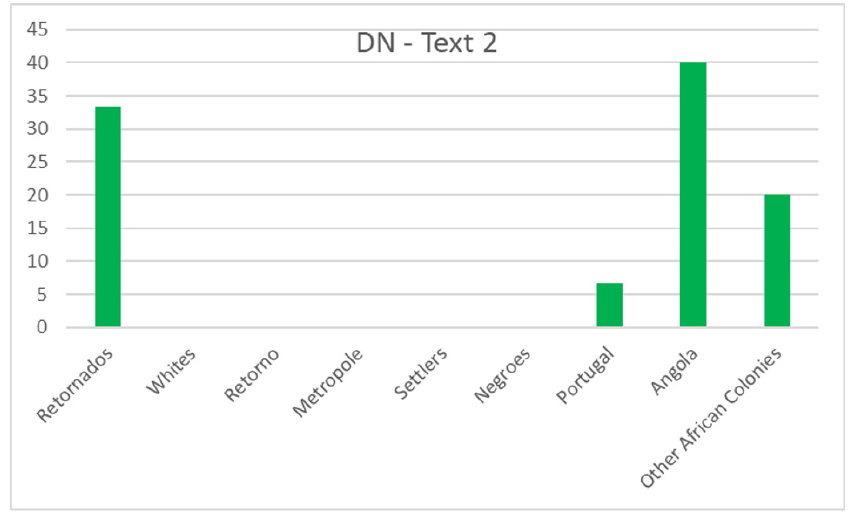
Figure 12. Most frequent words in the text “Retornados de África em 1975”. Source: Diário de Notícias (2016) [26].